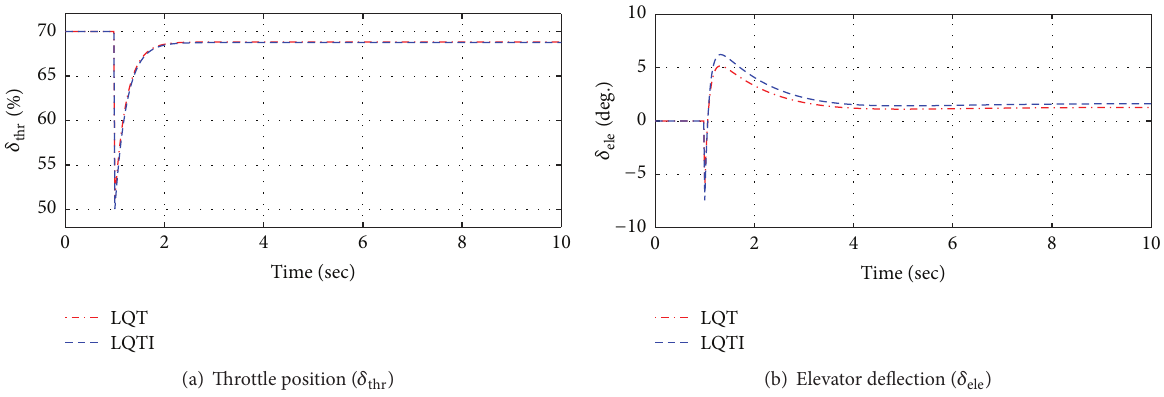
Figure 12: Time histories of the control inputs (Case 1).